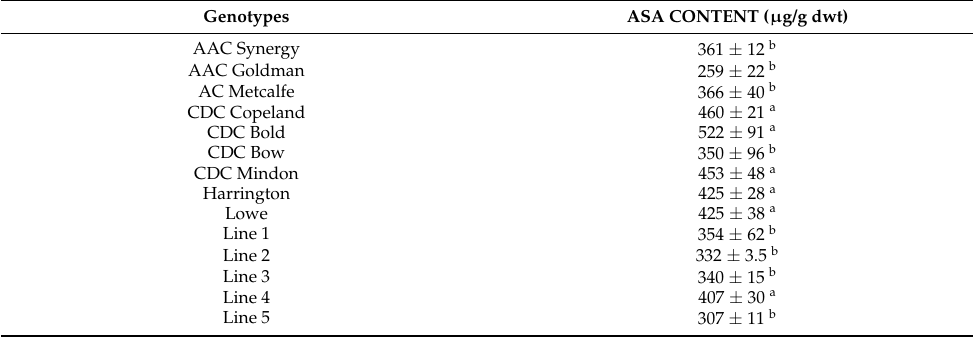
Table 2. Ascorbic acid (ASA) content ( µ g/g dwt) in tested barley grain samples. Genotypes